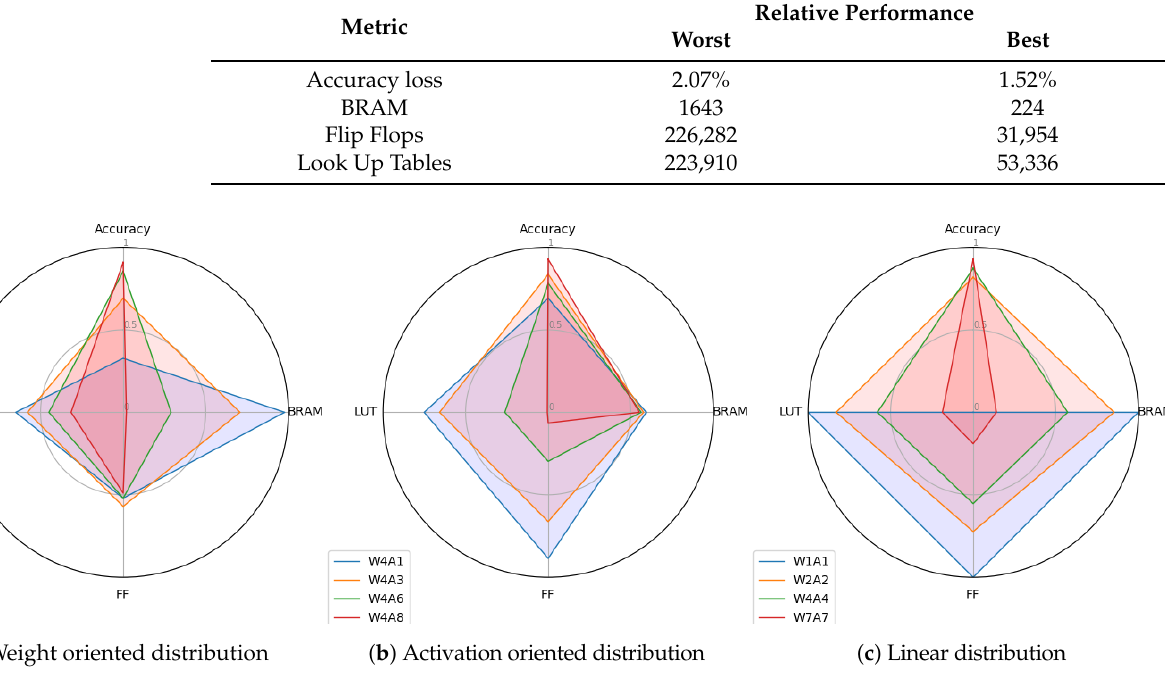
Figure 7. Radar charts for different quantisation configurations The radar plots compare the relative performance of these quantisation